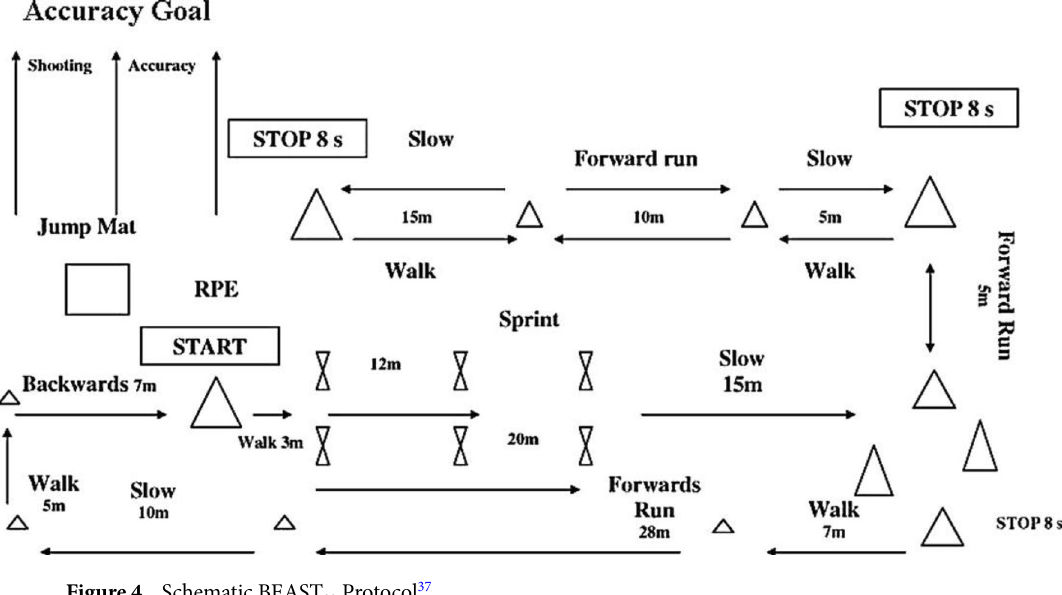
Figure 4. Schematic BEAST 90 Protocol 37